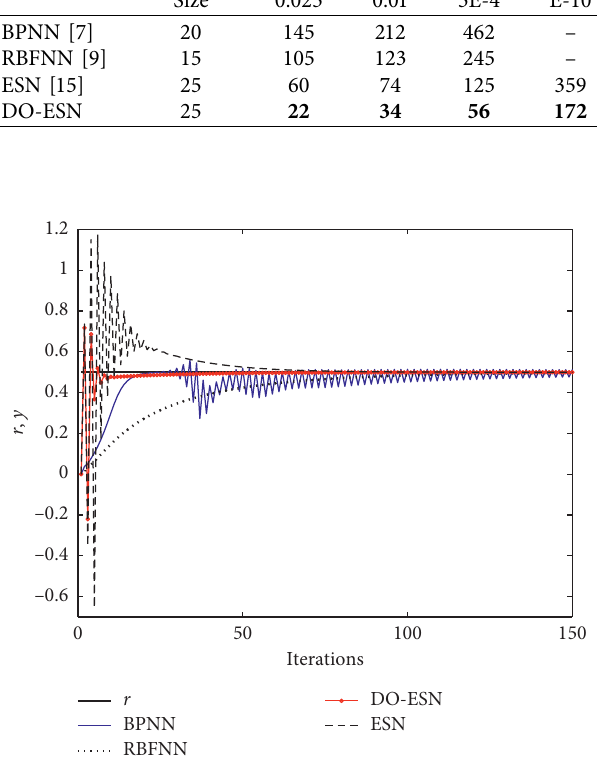
Figure 3: The output response curve of the control system.